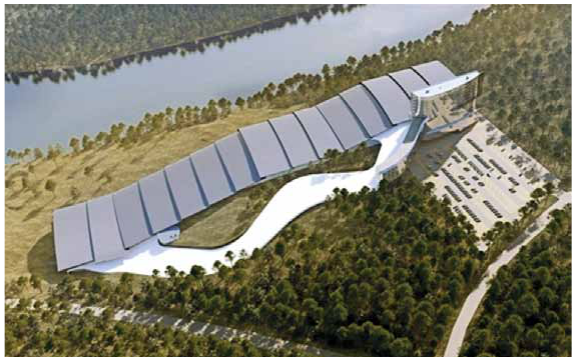
fig. 7. Snow arena in Druskininkai with an indoor ski slope made of artificial snow covering